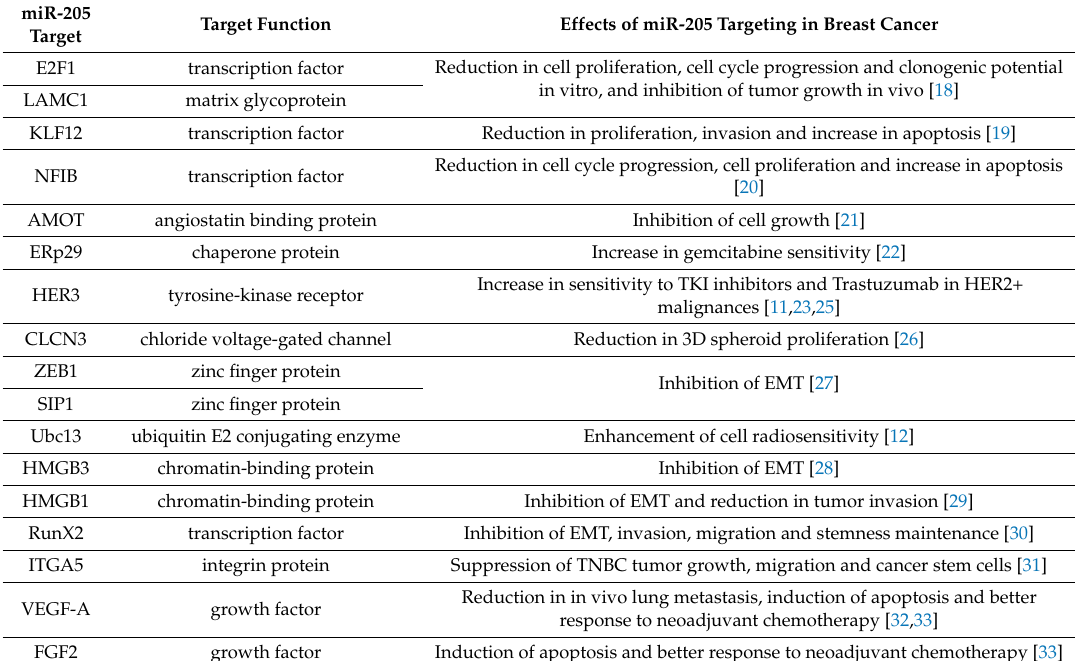
Table 1. Summary of miR-205 main targets and the consequent oncosuppressive effect in breast cancer cells. miR-205